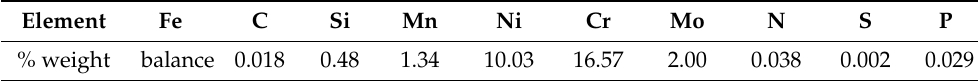
Table 1. Compositional analysis of the 316L stainless steel plates.